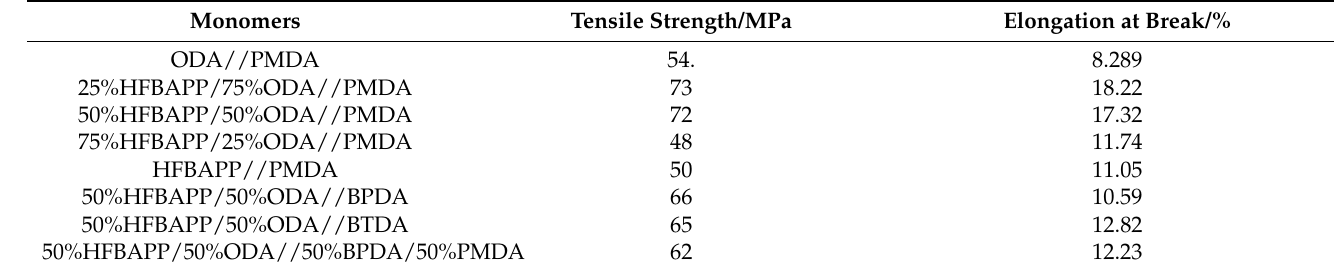
Table 4. Mechanical properties of PI films in group HFOP and group HFOB.